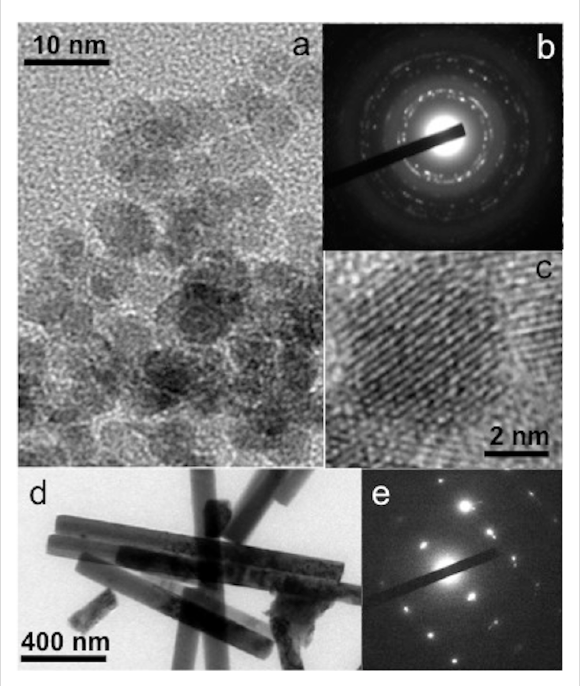
Figure 1: (a) Low-resolution TEM micrograph of ZnO nanoparticles, (b) electron diffraction pattern of the ZnO nanoparticles, (c) high- resolution TEM micrograph of a ZnO nanoparticle showing the lattice fringes, (d) low-resolution TEM micrograph of ZnO nanorods, and (e) electron diffraction pattern taken on a single ZnO